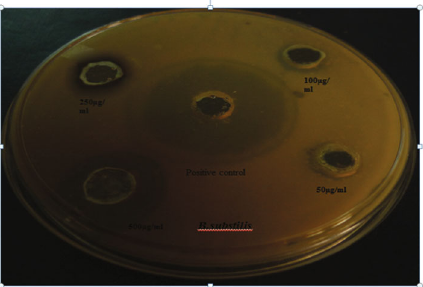
Figure 5: SEM analysis of SA-Ag-NP. Figure